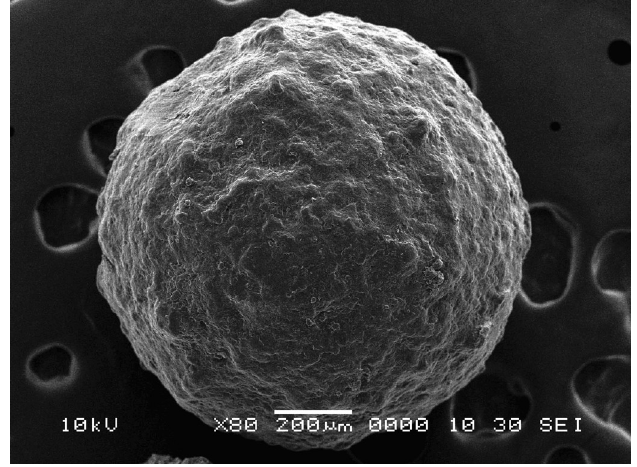
FIGURE 6 - Scanning electron microscopy of polymer coated pellets of an optimized batch F6 (X80).